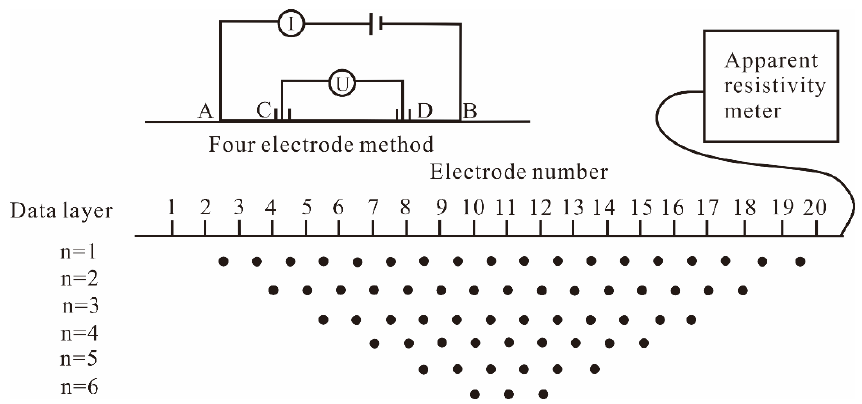
Figure 2. Schematic diagram of apparent resistivity acquisition.